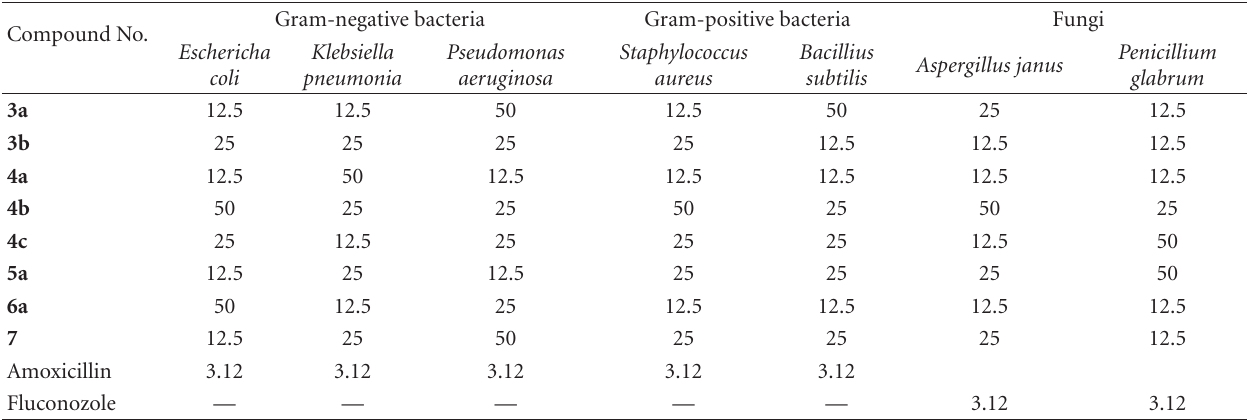
(Oxy)Bis(2-(Thiophen-2-yl)-4H-Chromen-4-One 2d . The bis- chromenone 2d was synthesized from the reaction of com- pound 1d (2.00 g, 0.0087 mole) with 4,4 (cid:2) -bis-chloromethyl- diphenyl (1.10 g, 0.0043 mole) under similar condition as described above for 2a